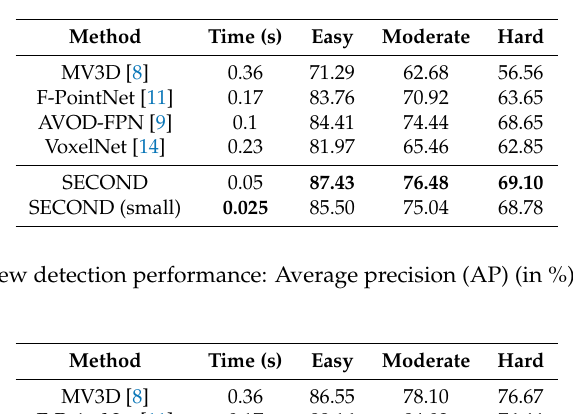
Table 4. 3D detection performance: Average precision (AP) (in %) for 3D boxes in the KITTI validation set.